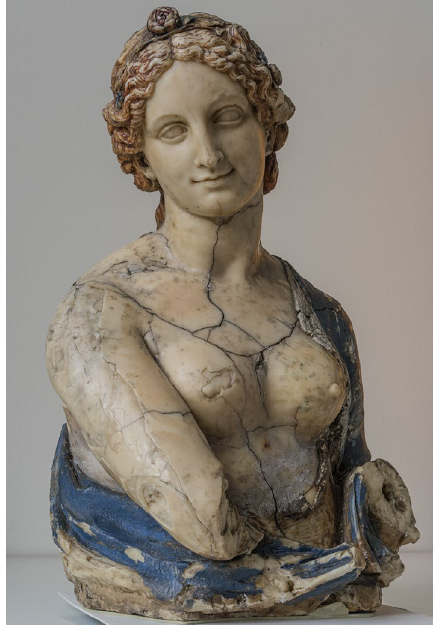
Figure 1. Flora bust, about 70 cm high, weight approx. 28 kg, Inv. No. 5951, Skulpturensammlung Museum für Byzantinische Kunst (SBM), Staatliche Museen zu Berlin (SMB), Stiftung Preußischer Kulturbesitz